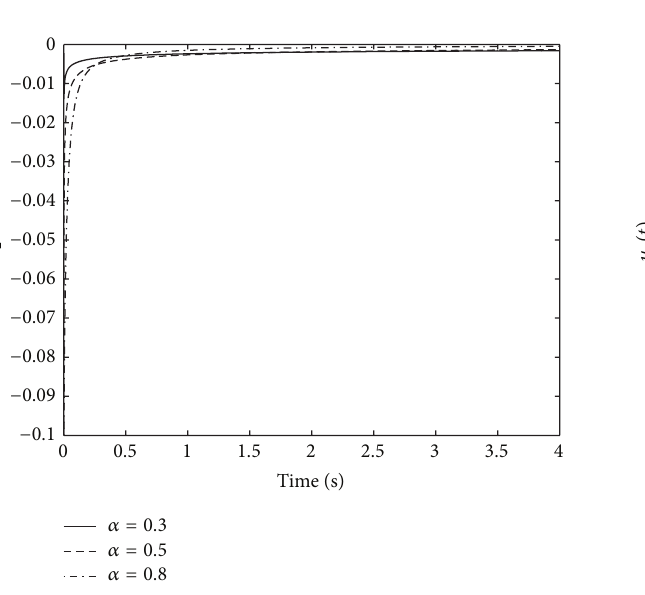
Figure 5: State response 𝑥 2 (𝑡) (0 < 𝛼 ≤ 1) .